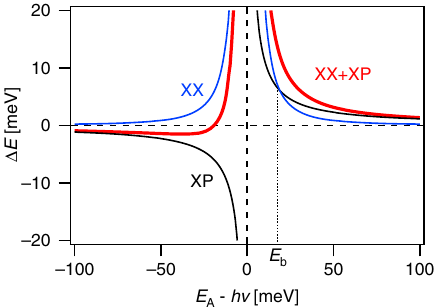
Fig. 4 Excitonic model of the optical Stark effect. Example calculation of the optical Stark shift predicted by the excitonic OSE model 33 in Eq. (6) (red), for h ν R = 5 meV, i.e. a Rabi frequency of 40 cm − 1 , and an exciton binding energy E b = 20 meV. The exciton − photon (XP, black) and exciton − exciton (XX, blue) contributions are shown.